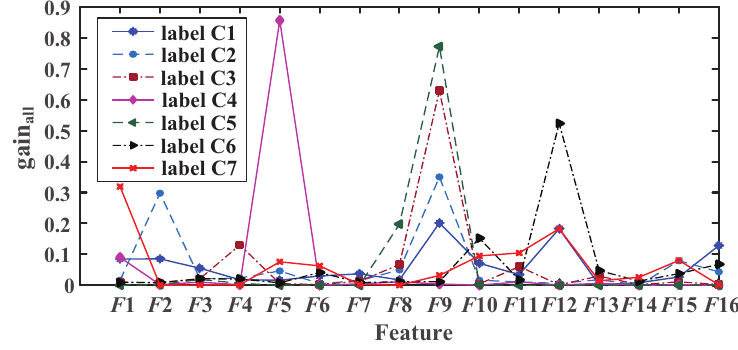
Figure 7. Feature importance